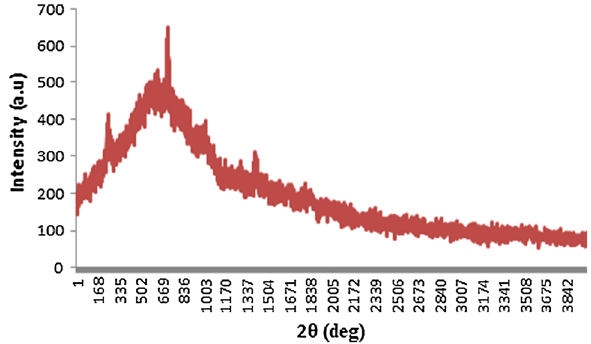
Fig. 4 XRD spectrum of TLP before adsorption